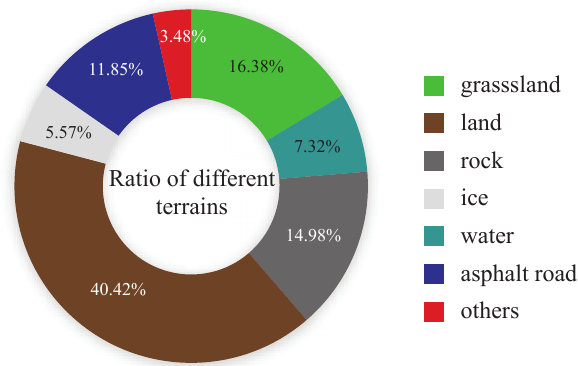
Figure 1. General statistics on the proportions of different terrains in 8 sites.